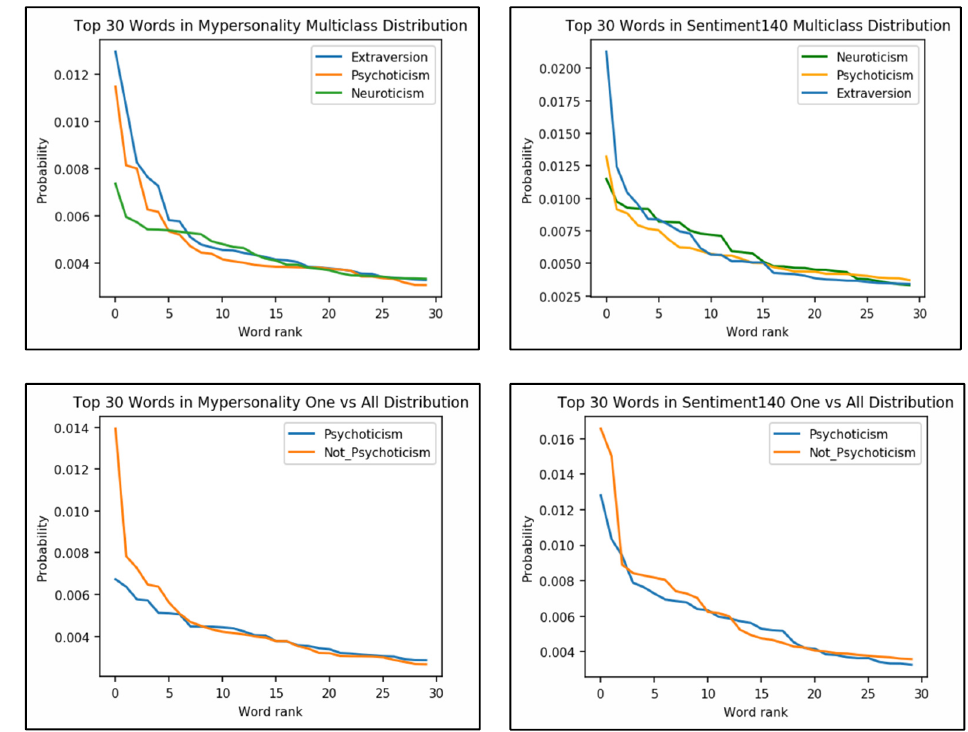
Figure 2. Probability distribution of the top 30 words.